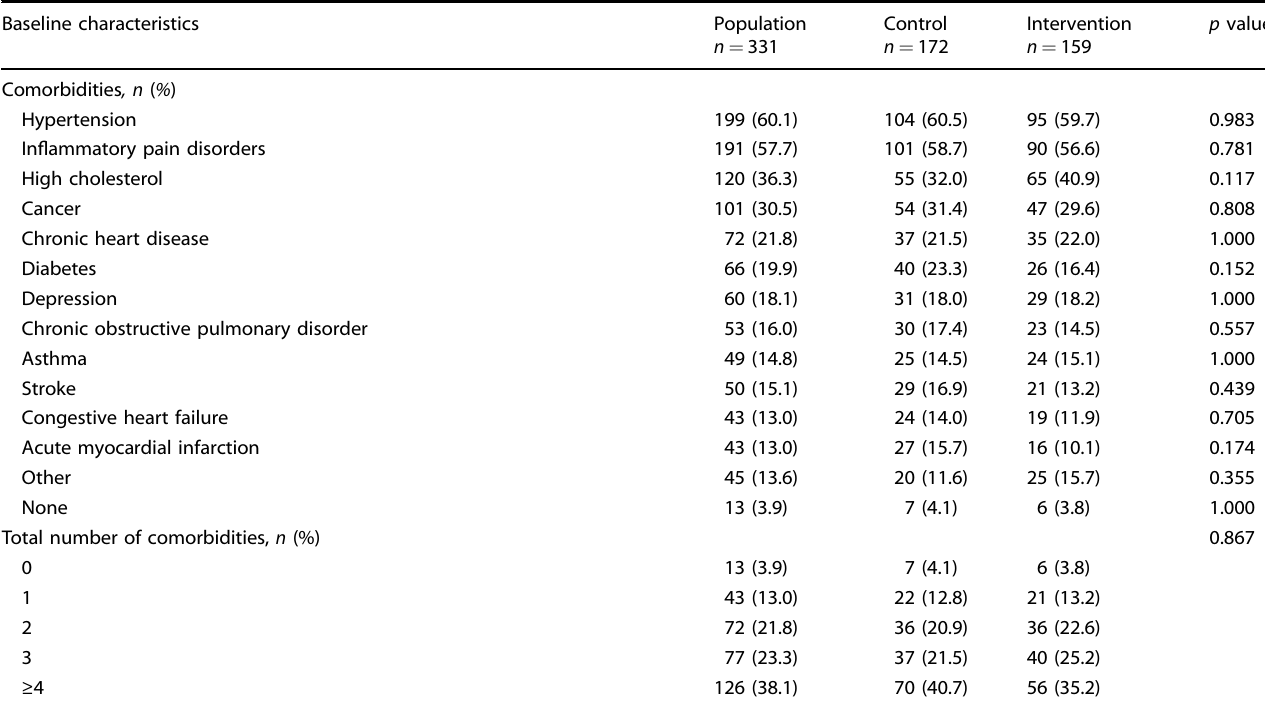
Table 2. Baseline characteristics by group — comorbidities. Baseline